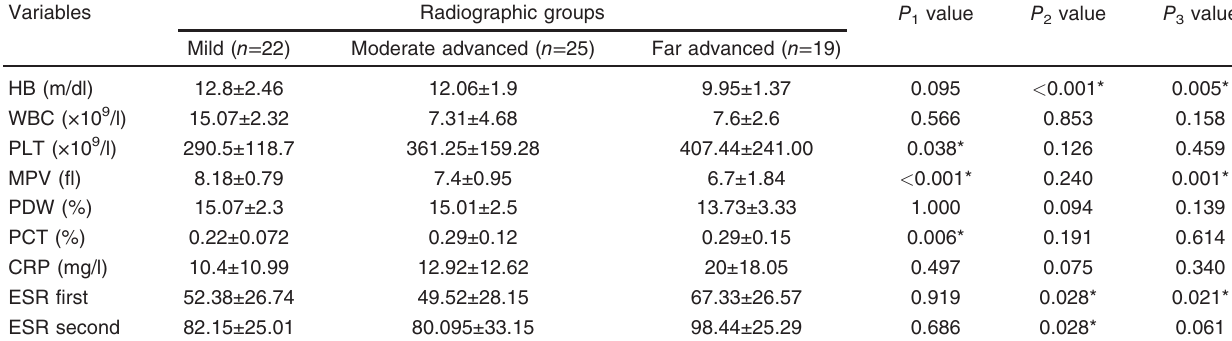
Table 3 Comparison of laboratory data among different groups of radiological extension